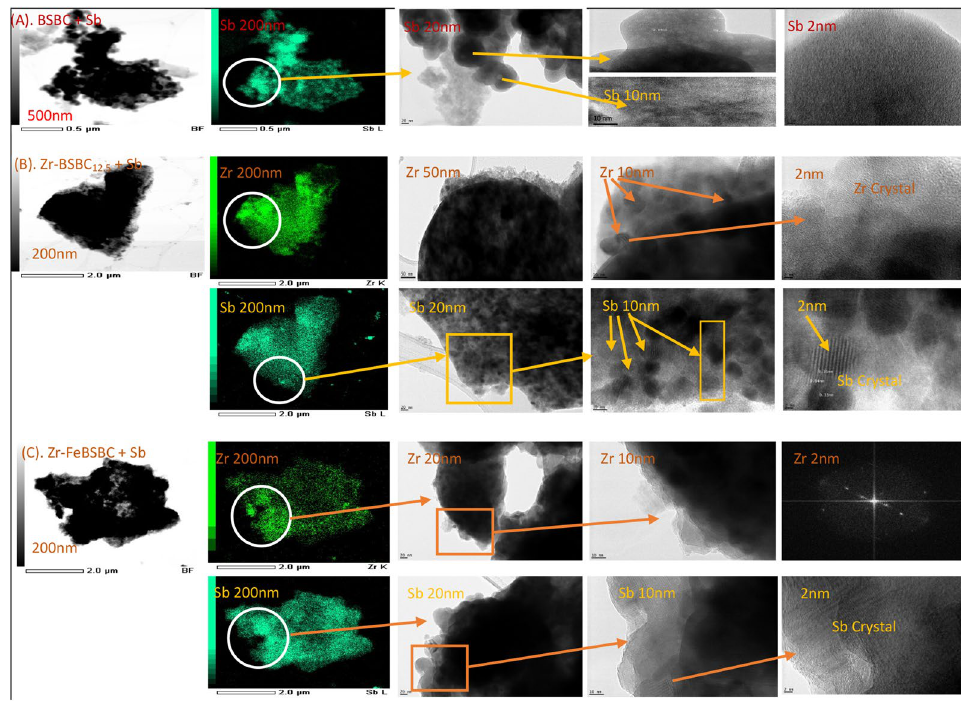
Figure 2. Different magnifications of Sb(V) and Zr onto Sb-loaded ( A ) BSBC, ( B ) ZrBSBC 12.5 , and ( C ) Zr-FeCl 3 BSBC biochars revealed by TEM imaging (Zr and